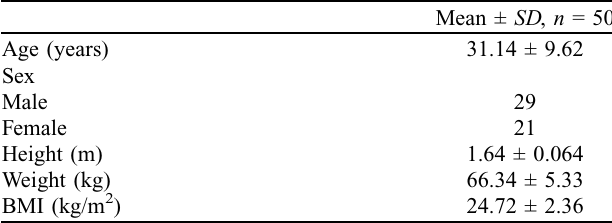
Table 1. Demographic data study population.